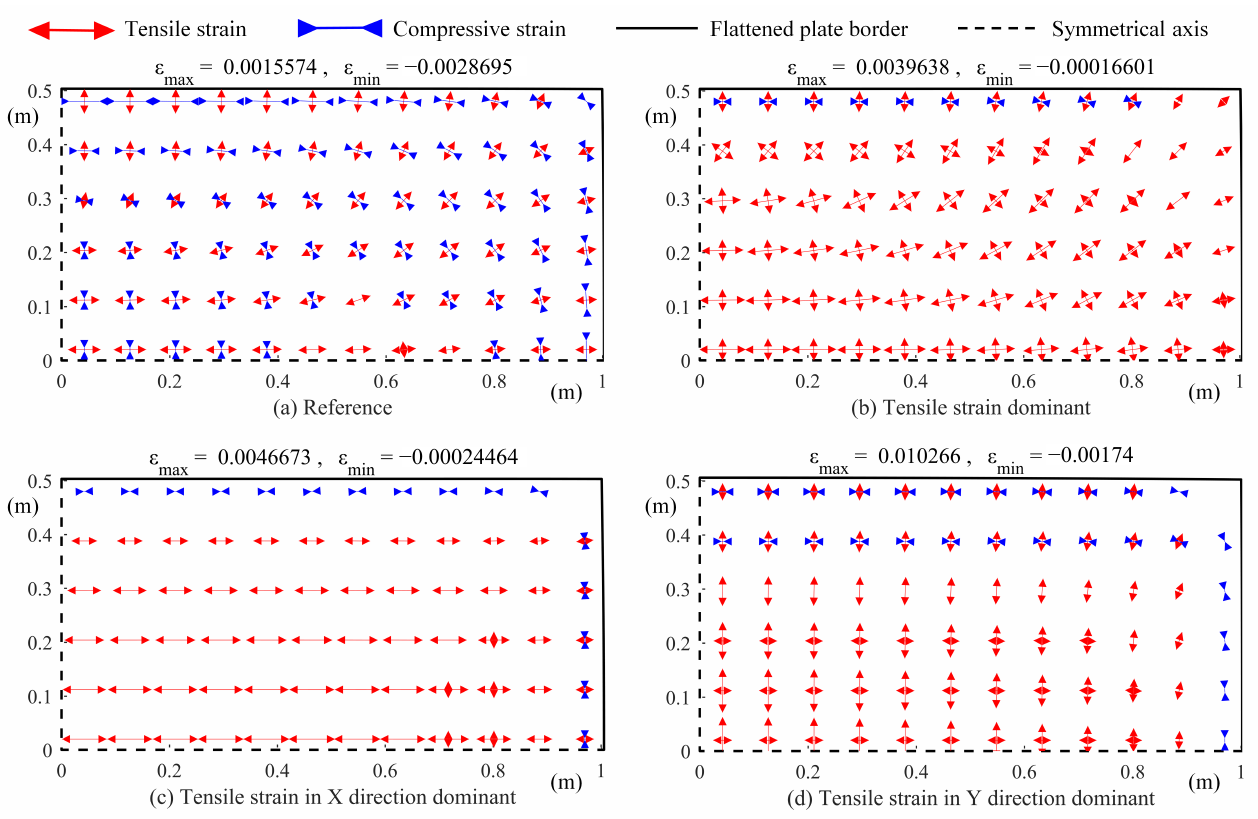
Figure 11. Principal membrane strain vector of saddle-shape flattening ( a ) reference, ( b ) tensile strain dominant, ( c ) tensile strain in X direction dominant, ( d ) tensile strain in Y direction dominant. Correspondingly, the saddle-shape surface-flattening has the central part